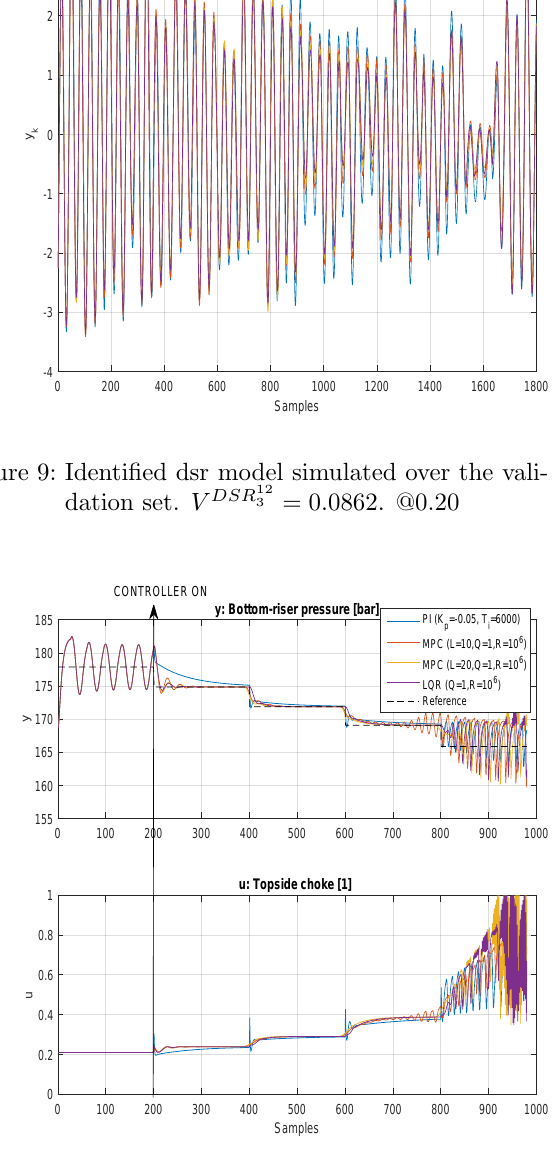
Figure 10: Four controllers, based @0.20, are imple- mented on the real process (Di Meglio), where each controller is turned on from starting point k = 200. We are compar- ing LQR, MPC (L=10), MPC (L=20) and PI. The PI controller is tuned using MAT- LAB Tuner Application. The weights for MPC and LQR are chosen the same values. Sampling time is 100